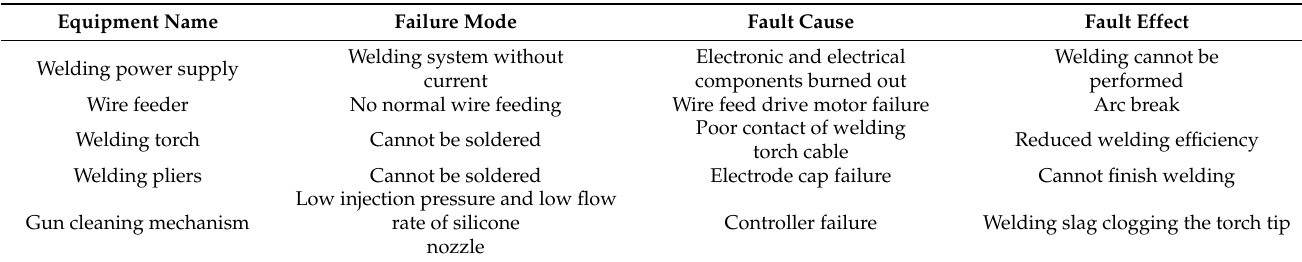
Table 1. Welding system failure